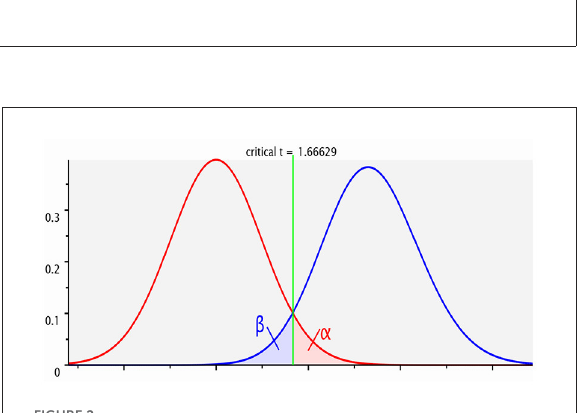
FIGURE2 Central and non-central